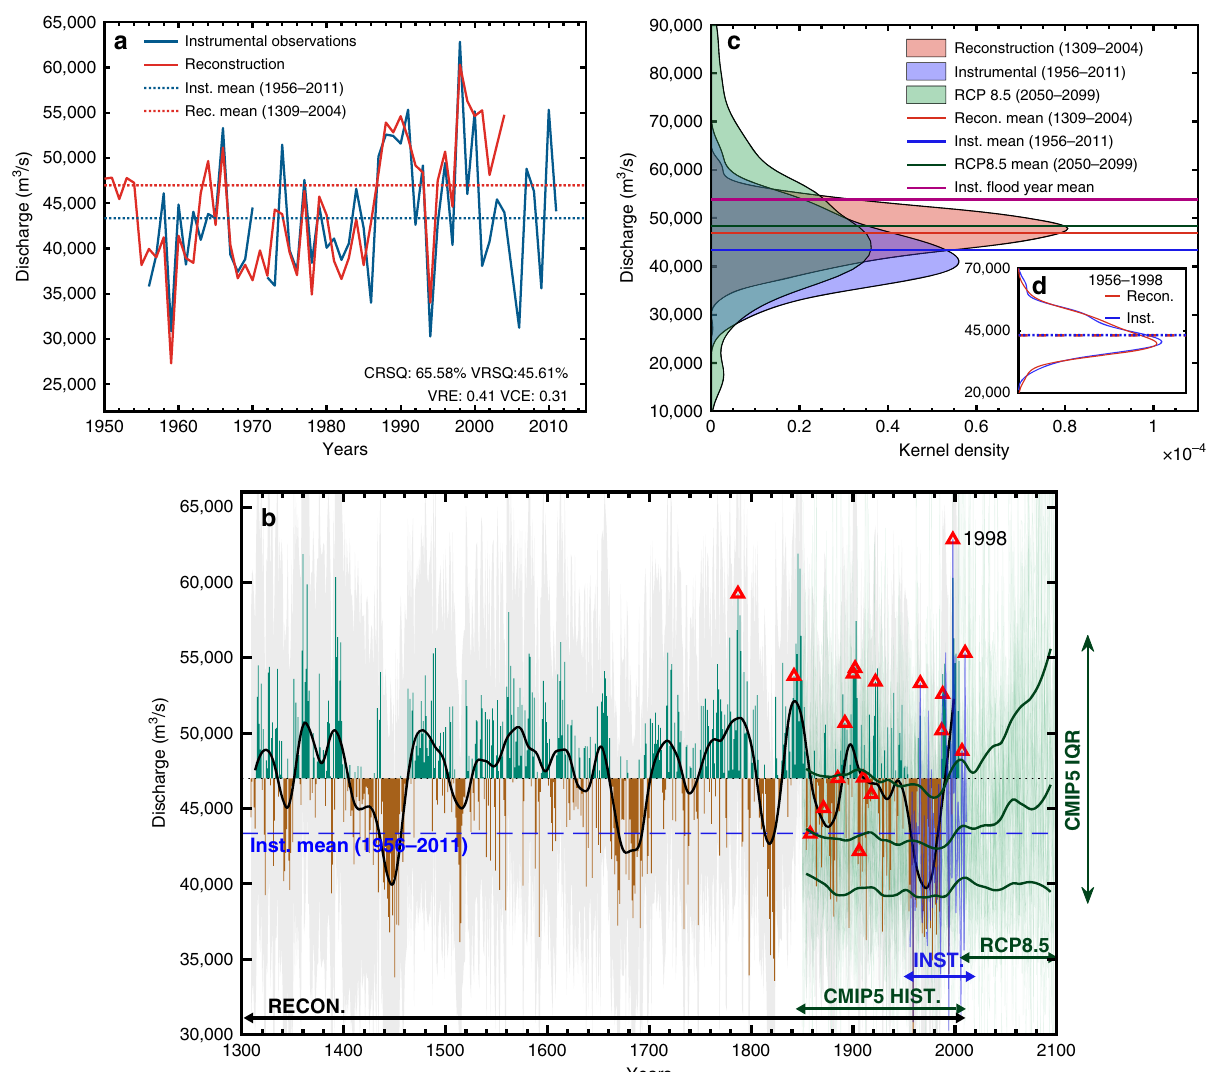
Fig. 3 Instrumental observations, the reconstruction, and CMIP5 projections of mean JAS discharge at Bahadurabad. a JAS instrumental discharge and its mean (43,350 m 3 /s) compared against reconstructed JAS discharge and its long-term mean (46,993 ± 812 m 3 /s). b Reconstructed discharge for each year between 1309 and 2004 C.E. as a departure from the reconstructed mean (as green and brown bars), along with the 50-year low-pass fi ltered reconstruction (solid black) highlighting multi-decadal variability. The instrumental JAS discharge and its mean between 1956 and 2011 C.E. is shown in the blue and dashed blue lines, respectively. Red triangles mark 18 documented fl ood years between 1787 and 2010 C.E. The 3 dark green lines represent the 50-year low-pass fi ltered interquartile range (IQR — 25th, 50th, and 75th percentiles) of the multi-model CMIP5 RCP8.5 ensemble (20 models; 42 runs; Supplementary Table 2) along with the full range of variability (light green lines) during both the ‘ historical ’ (1850 – 2005 C.E.) and ‘ future ’ (2006 – 2099 C. E.) simulation period of these runs. c Kernel density pro fi les of the median reconstruction (in red), instrumental period (in blue), the full 42 member CMIP5 RCP8.5 end of the century simulation period (2050 – 2099 C.E.) ensemble suite (in green) and their respective means. The observed mean discharge of the 6 instrumental period fl ood years from Fig. 2 are shown in purple. The inset fi gure d shows the kernel density pro fi les of mean JAS instrumental discharge (in red) and reconstructed mean JAS discharge (in blue) over the calibration-validation period (1956 – 1998 C.E.) along with their means. The reconstruction matches the features of instrumental discharge such at its mean and variance in this